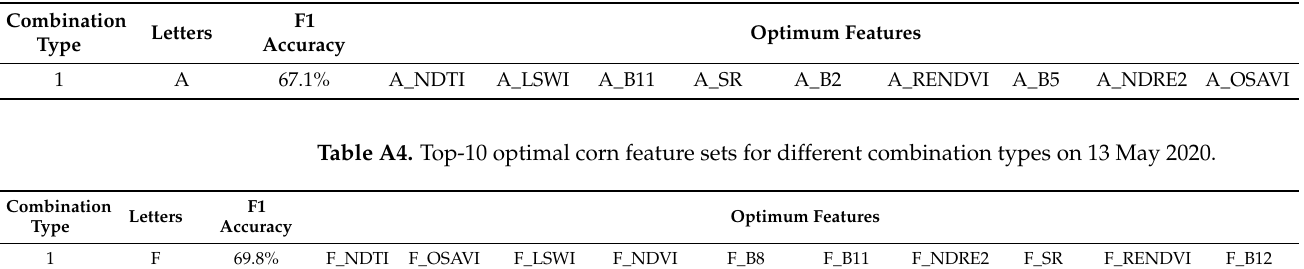
Table A3. Top-10 optimal corn feature sets for different combination types on 8 May 2020.